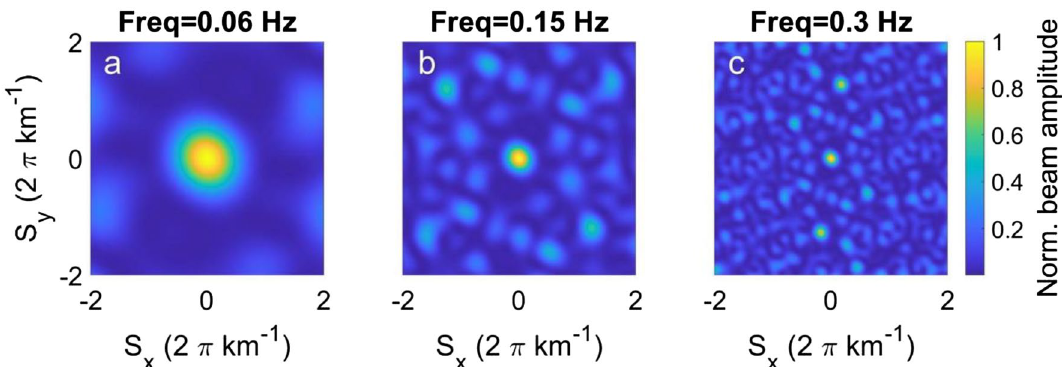
Figure 7. Array response functions of the fifteen stations composing the Mt. Etna seismic permanent network (see Fig. 1b) for a unit amplitude incident wave with slowness of 0 s/km at frequency of PM ( a ), SM ( b ), and SPSM ( c